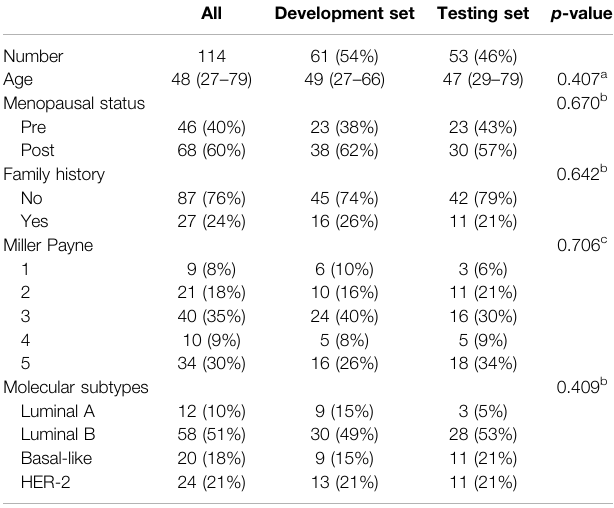
TABLE 2 | Patient